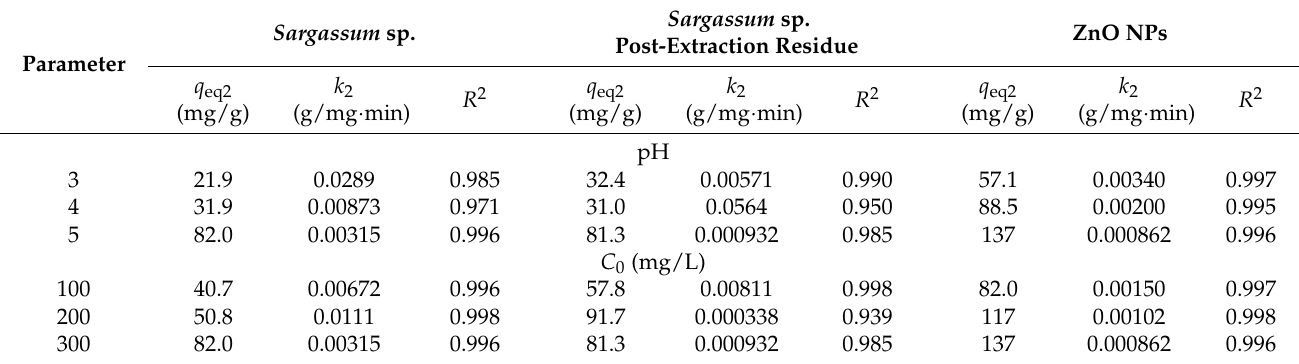
Table 4. Comparison of the parameters of the pseudo-second-order model at different pH ( C 0